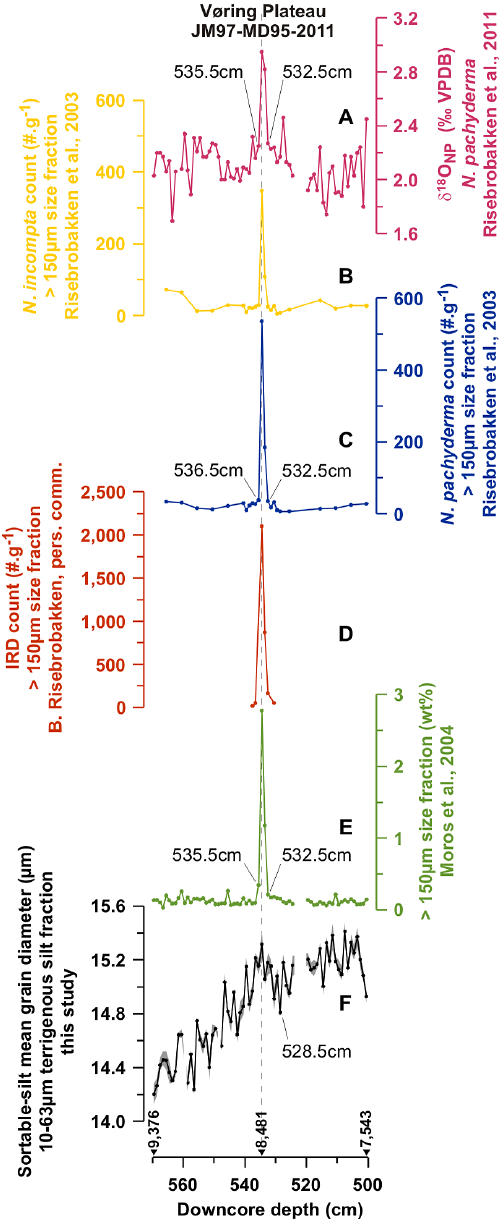
Figure 7. Changes in the coarseness of the sediments along the core as described by statistics based on the differential number distri- bution of grains within the samples. (a) The prominent maximum in the δ 18 O NP record (Risebrobakken et al., 2003e). Foraminiferan counts in the >150µm size fraction (Risebrobakken et al., 2003b): (b) N. incompta and (c) N. pachyderma . (d) Ice-rafted detritus (IRD) counts in samples bracketing the spike in the >150µm size fraction (B. Risebrobakken, personal communication, 2012). ( e ) Variations in the dry-weight percent of the >150µm size fraction (M. Moros, personal communication, 2012). (f) Changes in the coarseness of the 10–63µm terrigenous silt fraction as suggested by sortable-silt mean grain